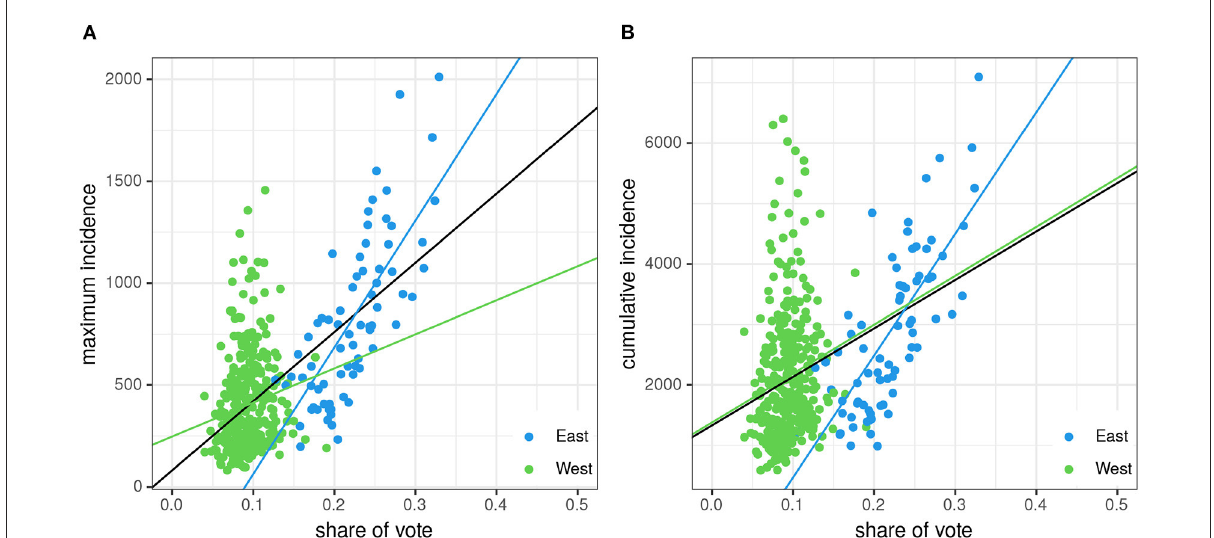
FIGURE1 Maximum 7-day-incidence per 100,000 (A) /cumulative 7-day-incidence per 100,000 (B) within/over the epidemic period [81–100] of the adult population by the AfD share of vote for the 411 rural districts. Data points corresponding to East German districts are depicted in blue, West German districts in green. Three linear regression lines are shown for the full set of points (black), only the East German (blue), and only the West German (green) parts,